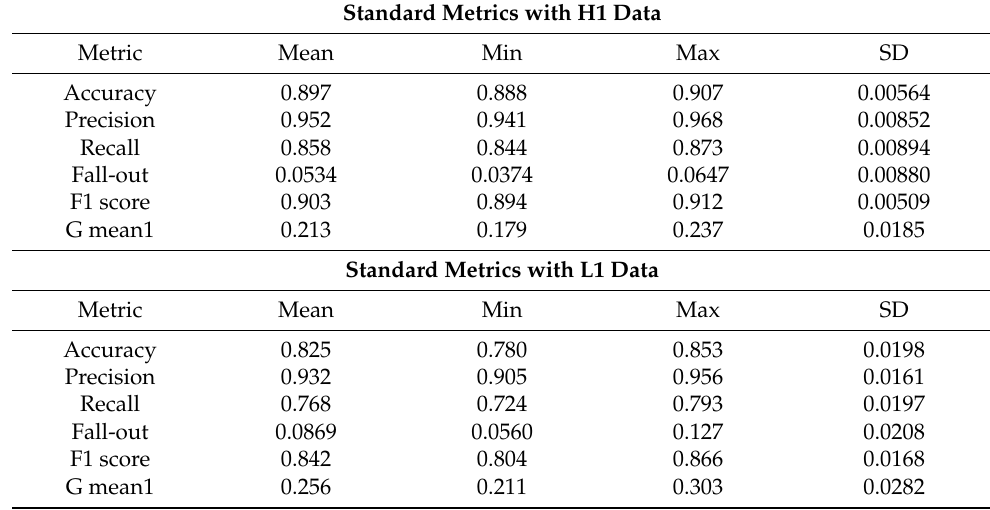
Table 3. Standard metrics computed from values of confusion matrices shown in Figure 9. We set our CNN with 32 kernels and 3 stacks with H1 data, and with 16 kernels and 2 stacks with L1 data. The time resolution is T win = 0.75 s. Except for the G mean1 reaching moderate results that could help to avoid over pessimistic (or optimistic) results, accuracy, precision, recall, fall-out, and F1 score showed that the CNN has a better performance working with H1